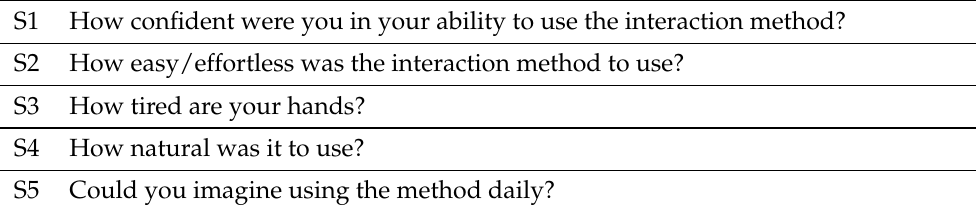
Table 2. The questions S1 to S5 that were asked to evaluate the subjective impressions of each individual interaction method.